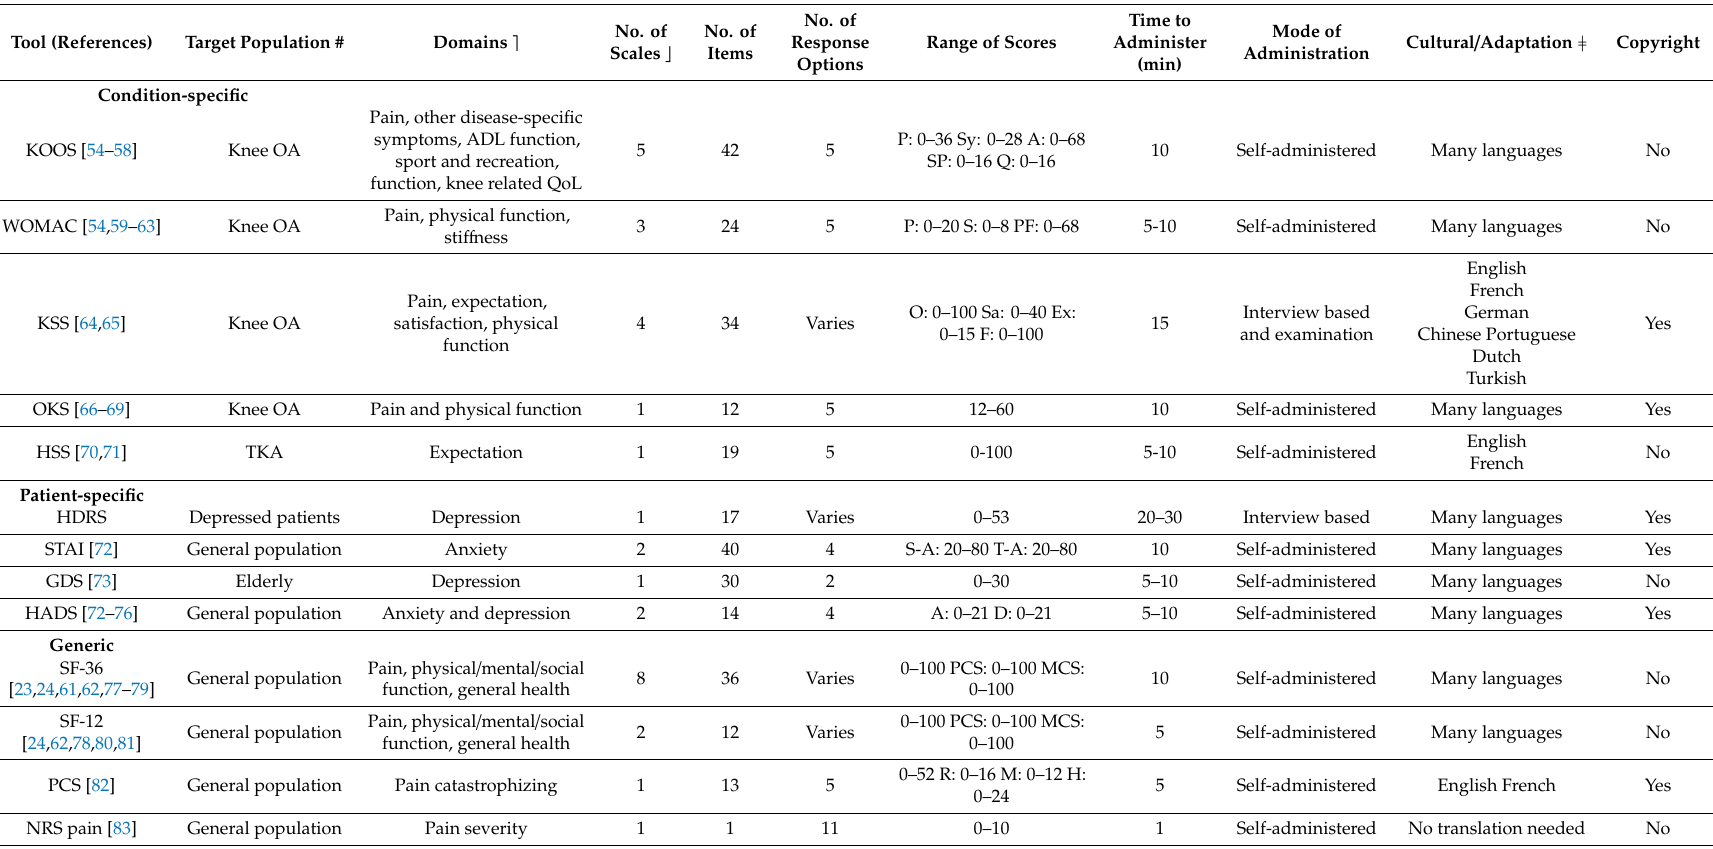
Table 3. Description of patient-reported outcome measures used for patient with knee OA undergoing total knee